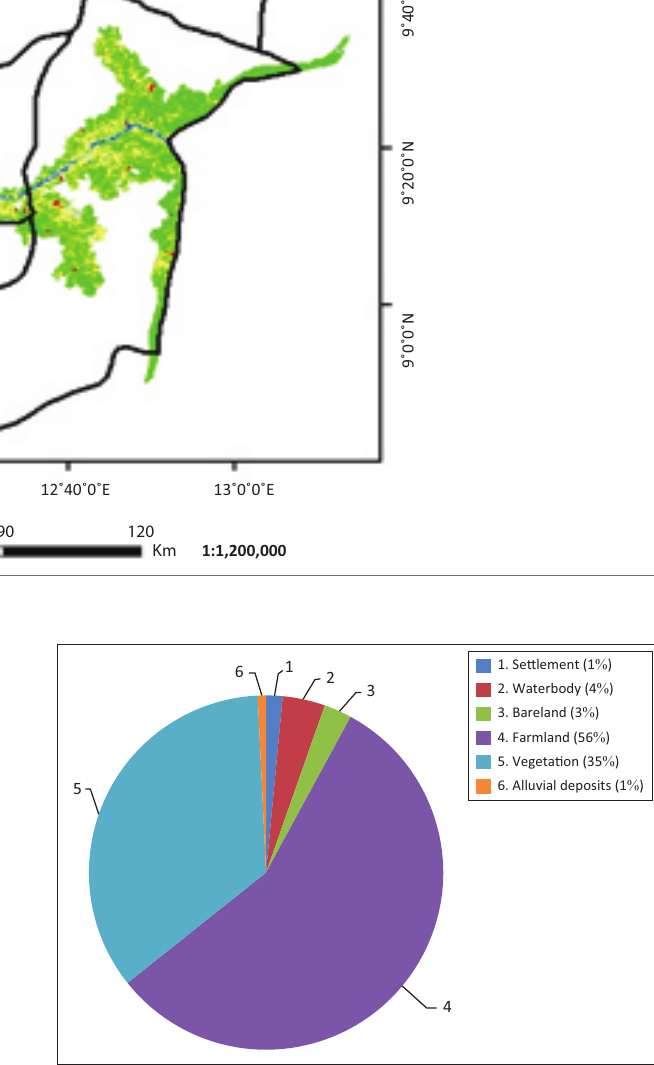
FIGURE 9: Land cover and/or land use affected by 2012 flooding in